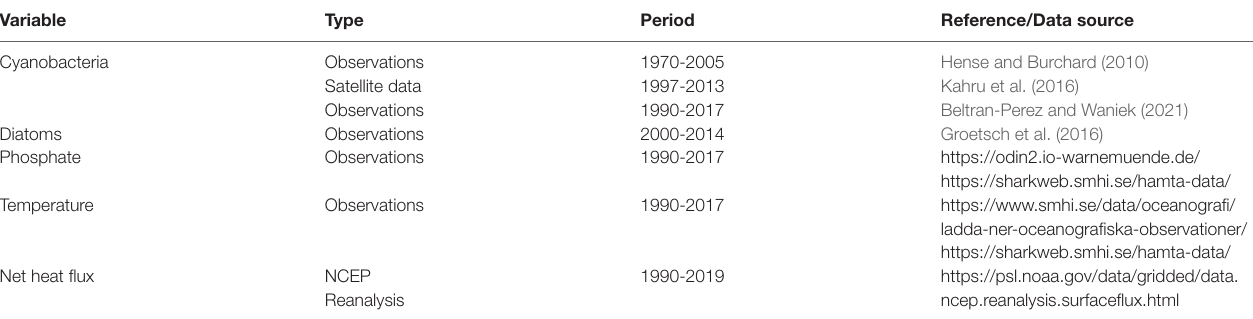
TABLE 3 | Data sets used for model setup and